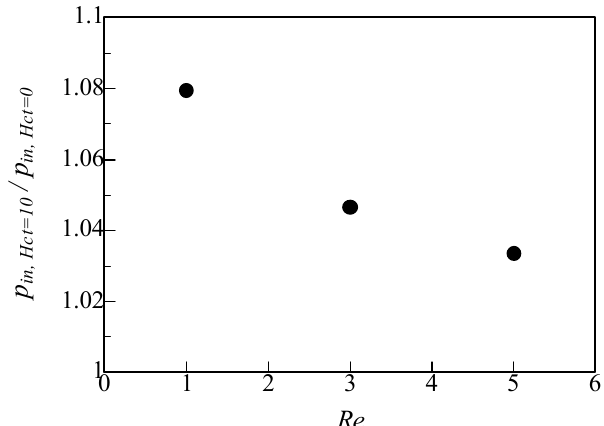
Fig.6 Effect of Re on the ratio of inlet pressure with Hct = 10% to that with